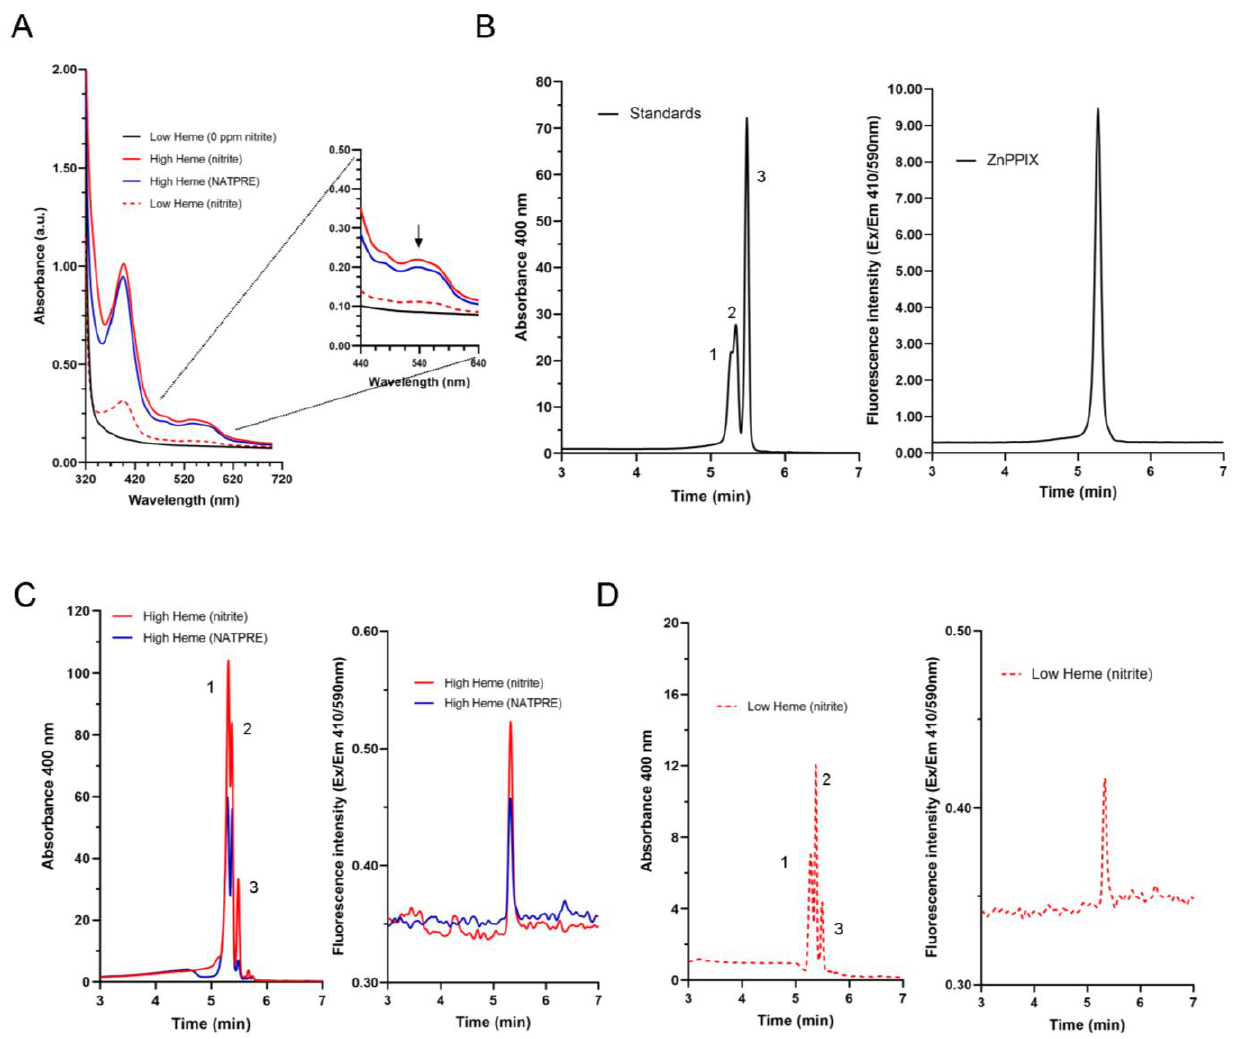
Figure 1. Analysis of pigments extracted from different cooked hams with 80% ( v/v ) acetone/water solution by HPLC-DAD-FLD. ( A ) Visible absorption spectra of pigments extracted from the studied cooked hams. Maximum absorbance at 540 nm is indicated with an arrow. ( B ) HPLC elution profile of a standard mixture of protoporphyrins (1 µg mL −1 ): 1, FePPIX; 2, ZnPPIX and 3, PPIX. ( C ) HPLC elution profile of pigments extracted from cooked hams made with high heme content muscles. ( D ) HPLC elution profile of pigments extracted from cooked hams made with low heme content muscles.